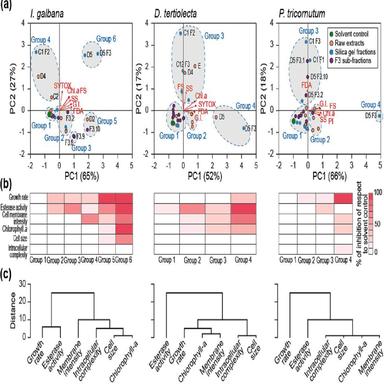
(a) PCA results of the three microalgal species and responses. Relationship between the inhibition of growth and cell viability endpoints (esterase activity, cell membrane intensity, chlorophyll a autofluorescence, cell size, and intracellular complexity). (b) The average value of the toxic response induced by samples included in each group. (c) Results for cluster analysis based on growth rate and inhibition of cell viability.